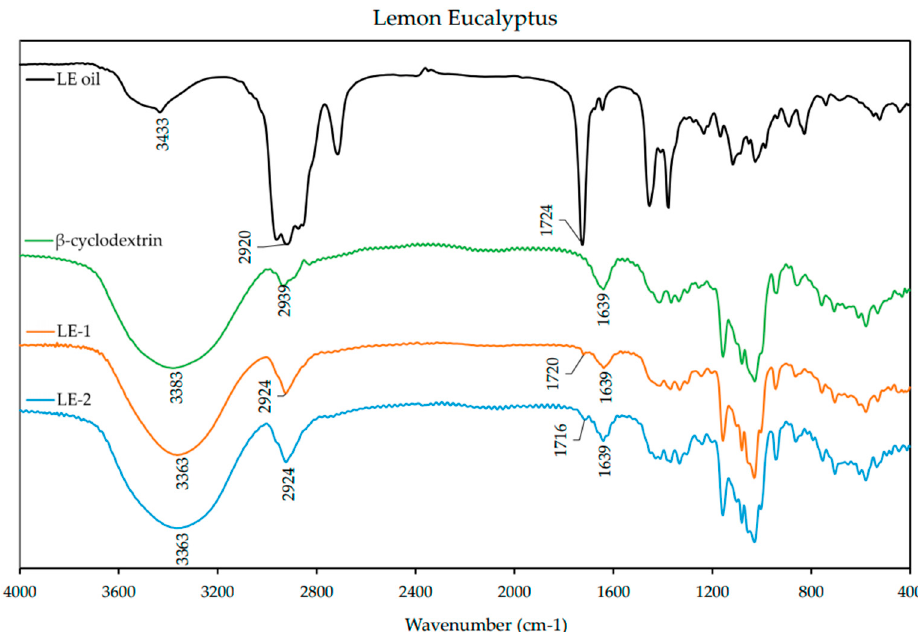
Figure 5. FT-IR spectra of lemon eucalyptus (LE) essential oil, β -cyclodextrin, and inclusion com- plexes LE-1 and LE-2. Spectra were obtained from 400–4000 cm − 1 with a resolution of 3.857 cm − 1 as an average of 32 scans on FT-IR spectrophotometer.